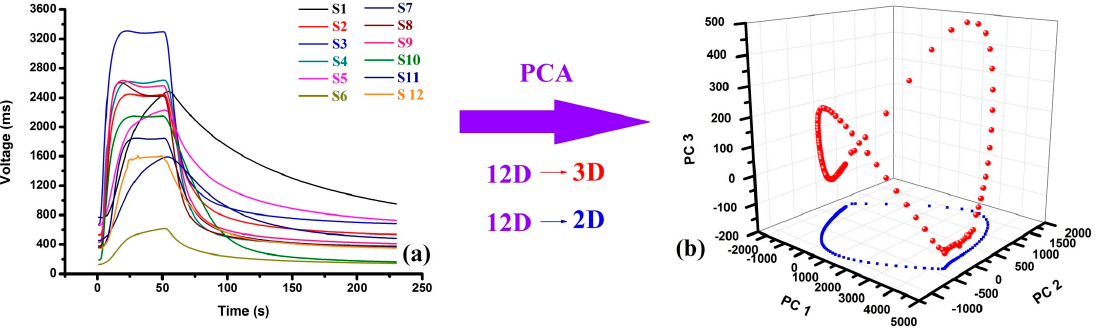
Figure 4. The compression process of the original response by principal components analysis (PCA): ( a ) the original signals, ( b ) the compressed signals.